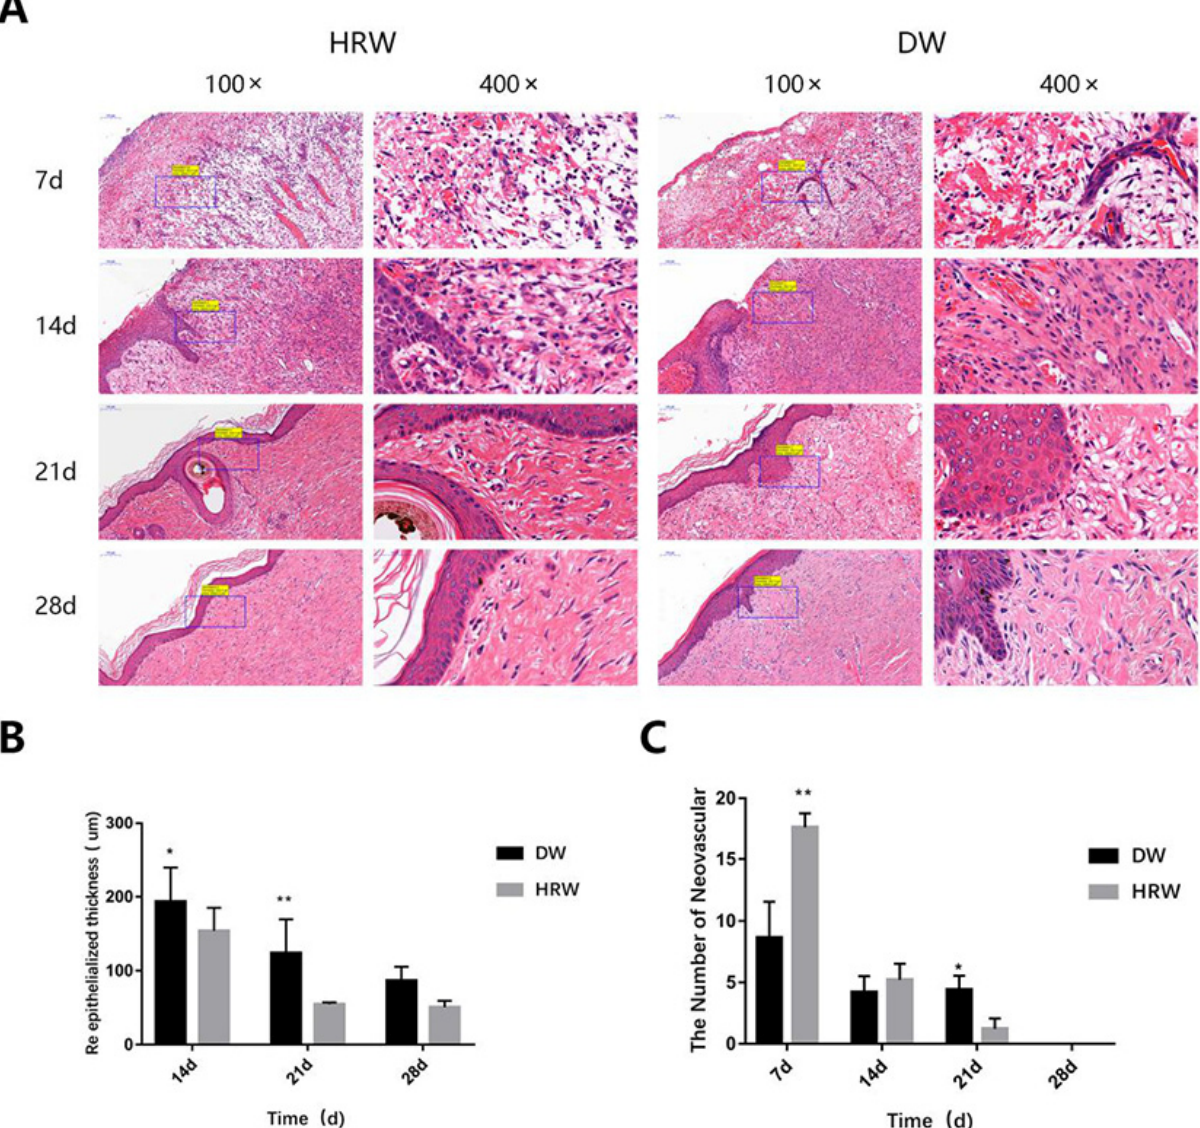
Figure 5. ( A ) H&E section of the skin wound. Angiogenesis, granulation tissue, and re-epithelialization were observed by H&E staining. ( B ) Re-epithelialized thickness. H&E samples were observed, and the epidermal thickness at the wound edge was measured using ImageJ. ( C ) Average number of blood vessels. The number of neovascular structures in skin tissue were assessed by H&E staining of the paraffin-embedded section. * p < 0.05, ** p < 0.01.